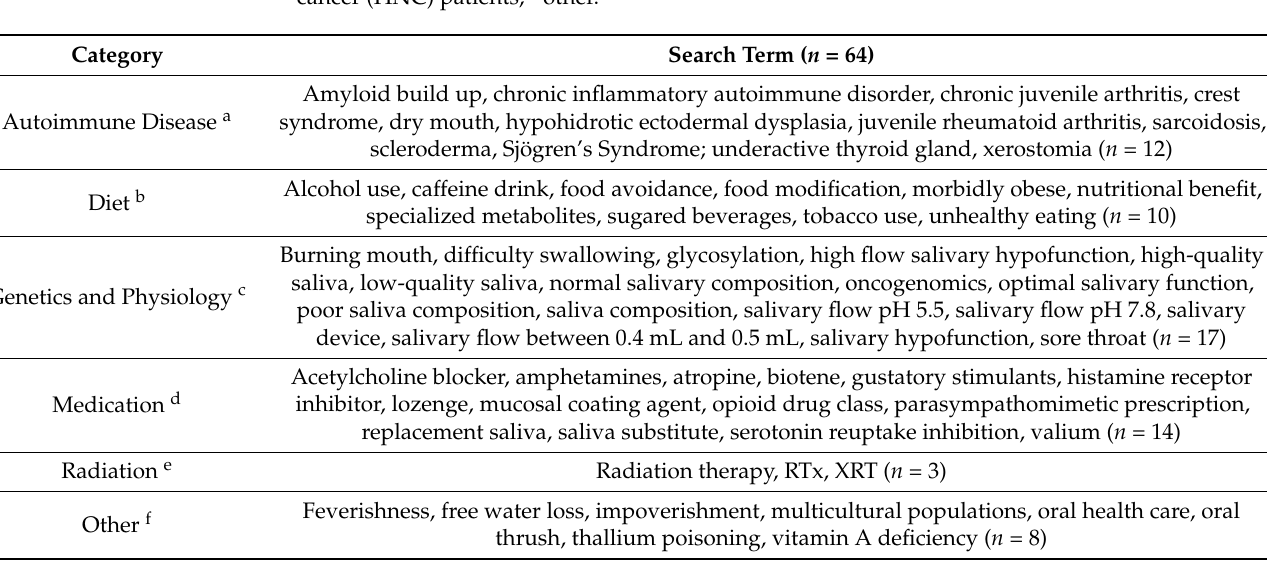
Table 1. Xerostomia and/or Dry Mouth Search Terms. Search terms ( n = 64) were determined using conventional methods. PubMed and PubMed Central were used to search for articles in English relating to xerostomia and/or dry mouth. Keywords or “search terms” thought to be linked to xerostomia and/or saliva were selected. Search terms were split into categories directly related to the etiology and/or pathobiology of xerostomia and/or dry mouth: a autoimmune conditions; b dietary and nutritional; c genetic and physical; d medication; e radiation therapy applied to head and neck cancer (HNC) patients; f